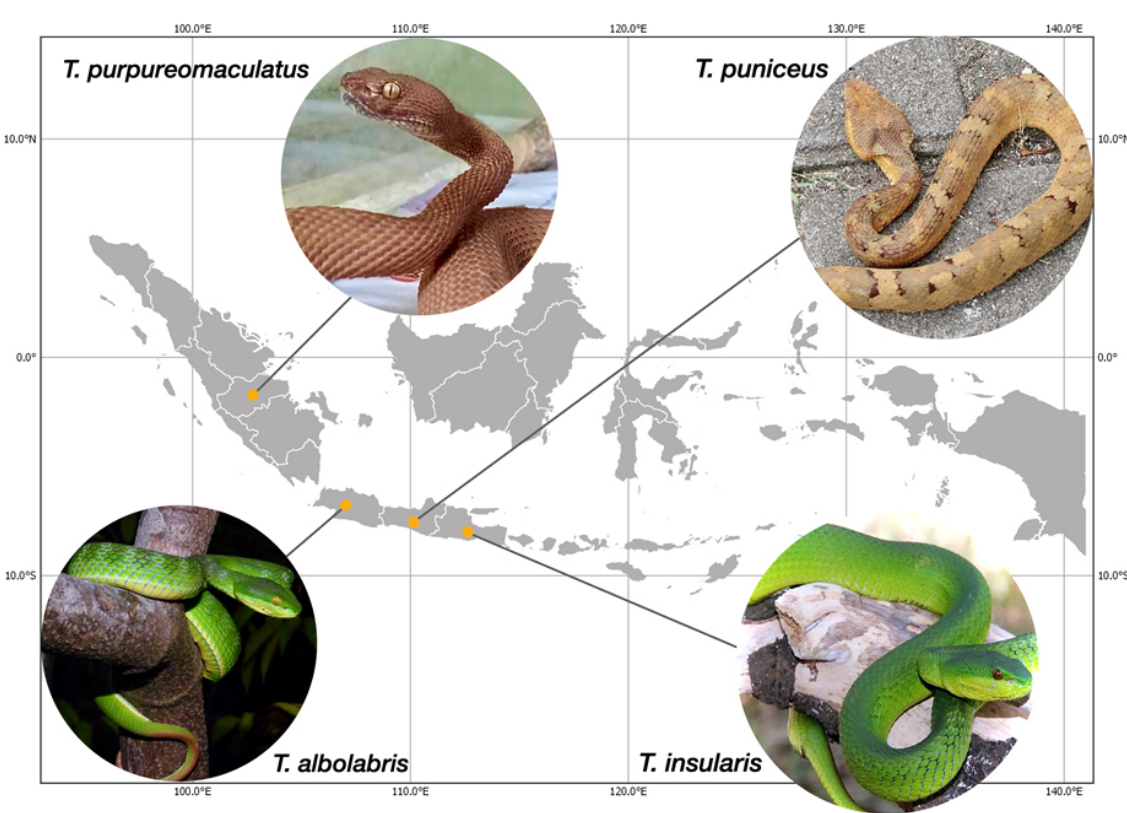
Figure 2. The geographical origin of the four species analyzed in the present study. All species can be easily differentiated from each other by their morphological features except for T. albolabris and T. insularis . The yellow circles represent the sample